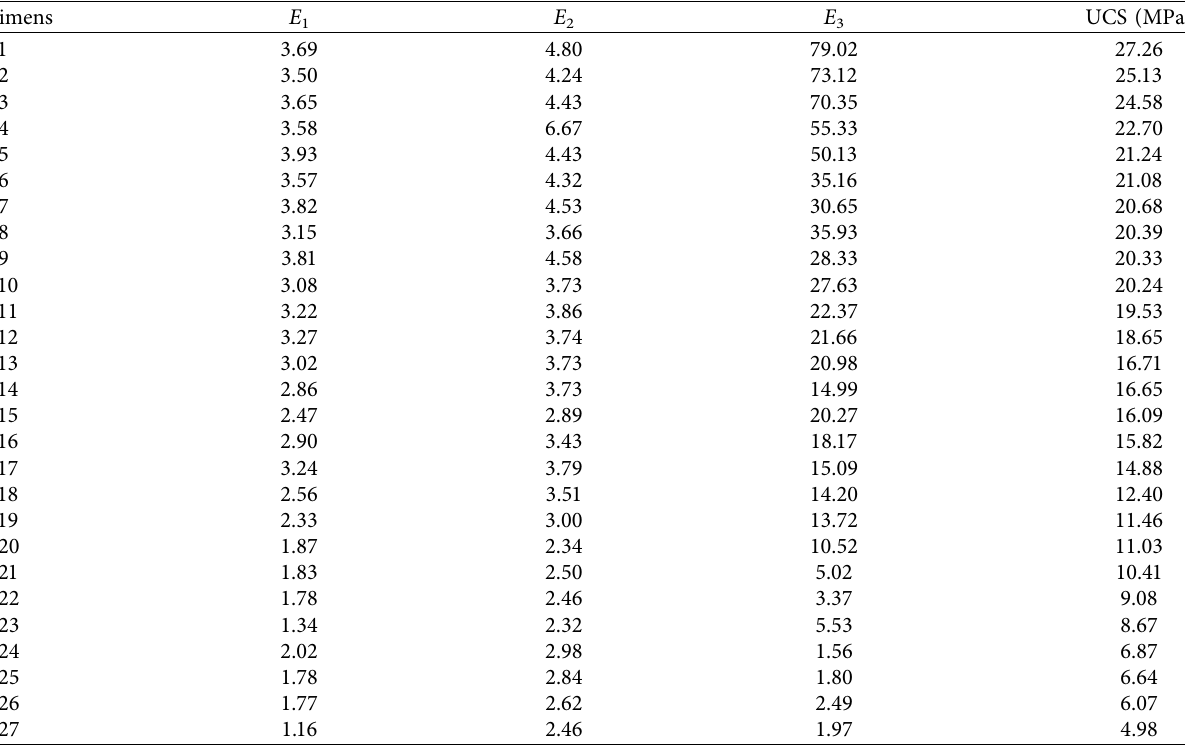
Table 5: Parameters of E 1 , E 2 , and E 3 of stress-strain curve before peak strength, unload curve before 80–90% of peak strength, and curve after peak strength of the 27 coal specimens.